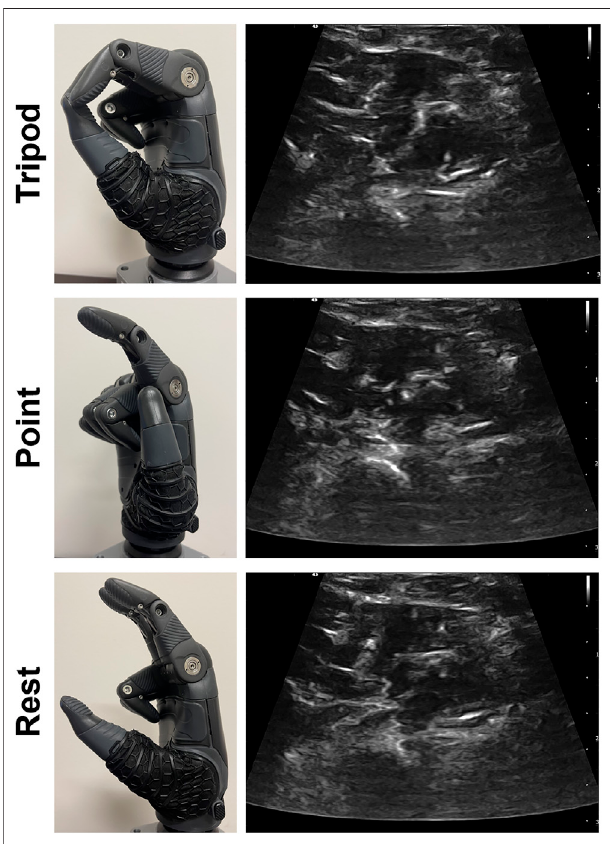
FIGURE 3 | The TASKA hand was con fi gured to include tripod grasp, index fi nger point , and rest . Each grasp was initiated in response to a different muscle activation pattern, including wrist fl exion for tripod , wrist extension for point , and a relaxed muscle state for rest . Representative ultrasound images are included for each muscle activation